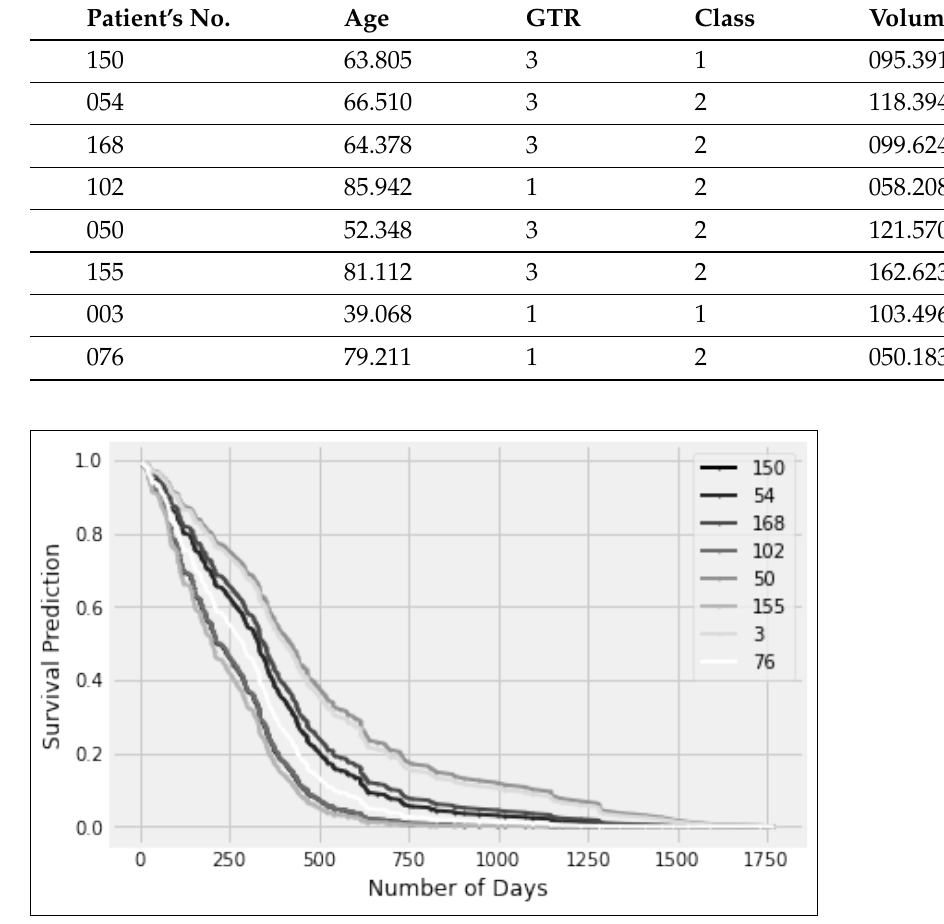
Figure 10. Survival rate of multiple